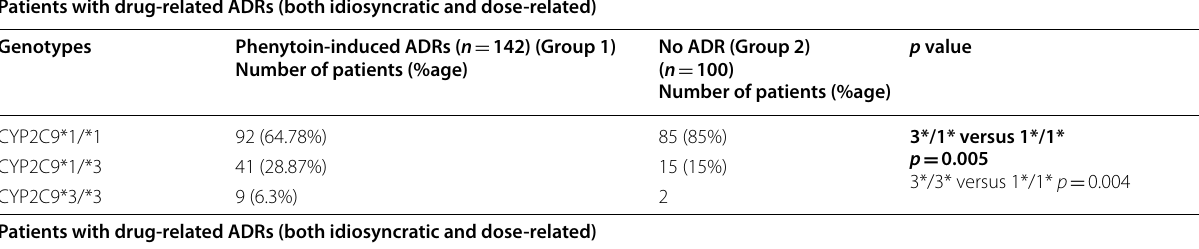
Table 2 Comparison of CYP2C9*1 and CYP2C9*3 among study groups Patients with drug-related ADRs (both idiosyncratic and dose-related) Genotypes